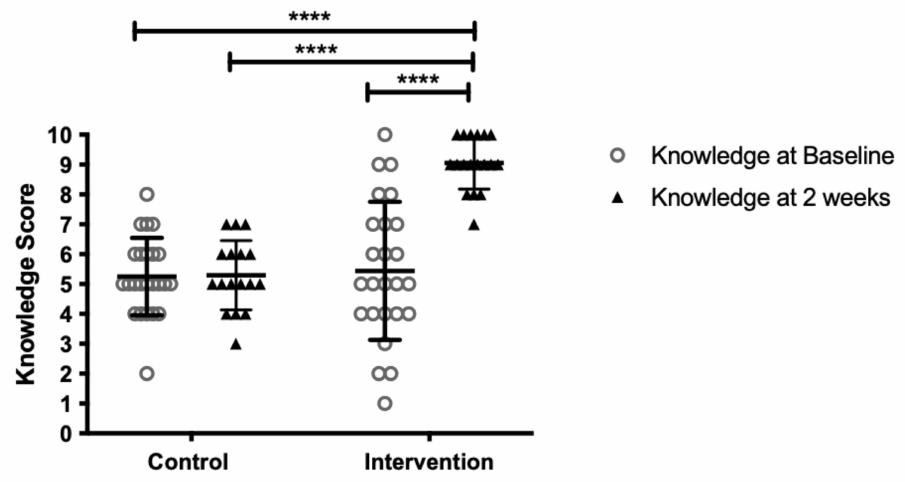
Figure 2. Knowledge Assessment Scores at baseline and at 2 weeks in the control ( n = 25 at baseline, n = 17 at week 4) and intervention ( n = 25 at baseline, n = 18 at week 4) groups. Bars represent the mean and standard deviation; **** p < 0.0001 as assessed by one-way